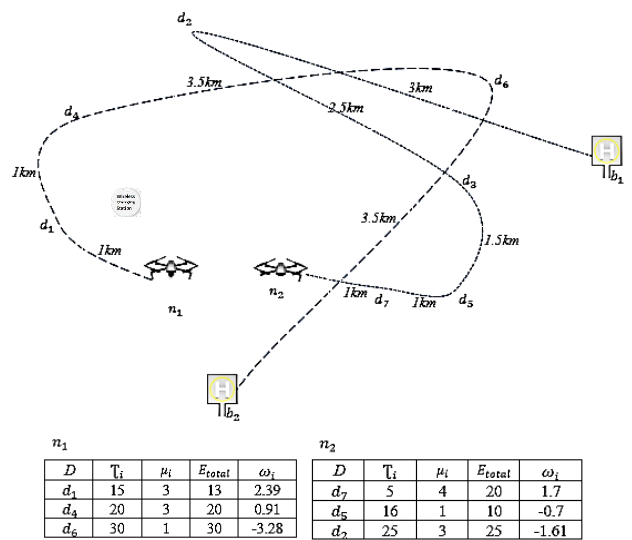
Electronics 2019 , 8 , x FOR PEER REVIEW Figure 1. Original flight paths of two drones. Figure 1. Original flight paths of two drones.